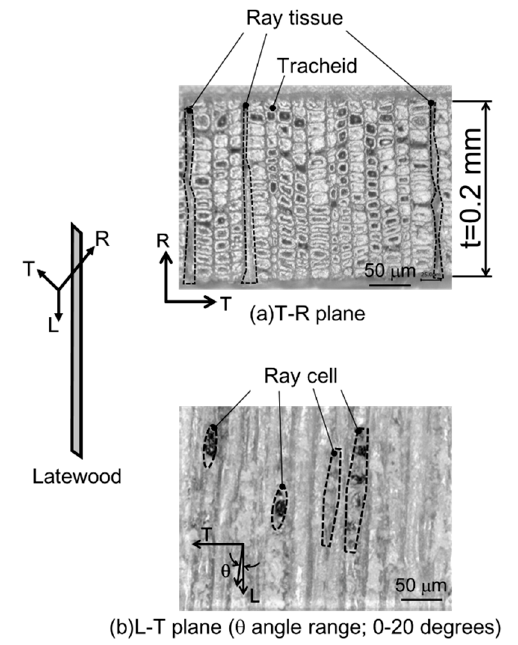
Figure 4. Microstructures in the two orientations in the latewood specimen: T-R plane ( a ) and L-T plane ( b ).